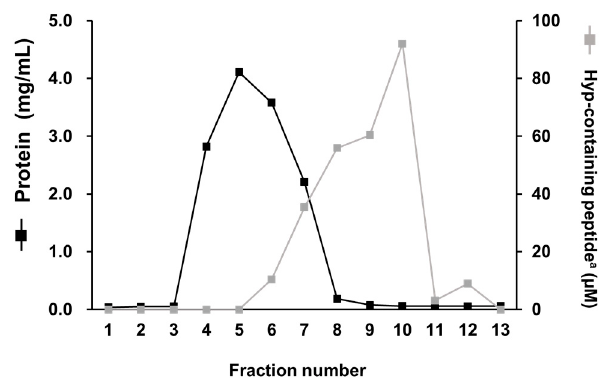
Figure 3. Elution of protein and hydroxyprolyl peptide in FBS-1 from the Econo-Pac 10DG column; ( ■ ), protein; ( ■ ), Hyp-containing peptide; a peptide form of Hyp.